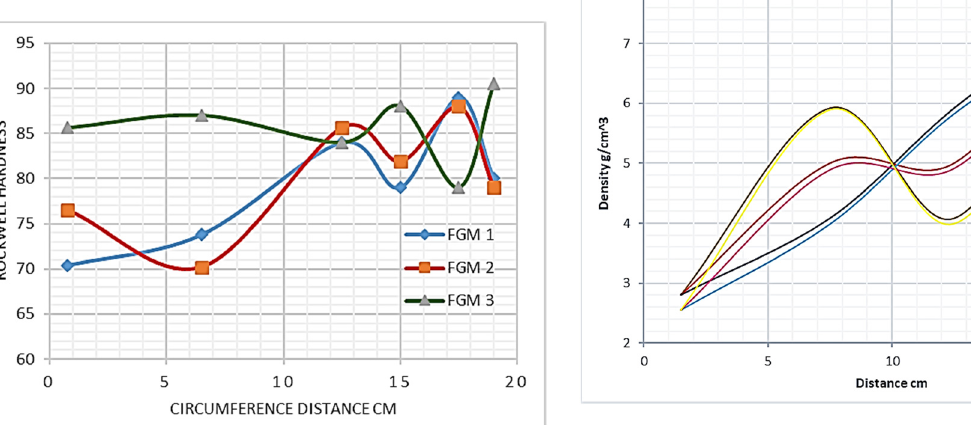
Figure 16: Experimental and theoretical densities of FGMs and the FGM rod ’ s